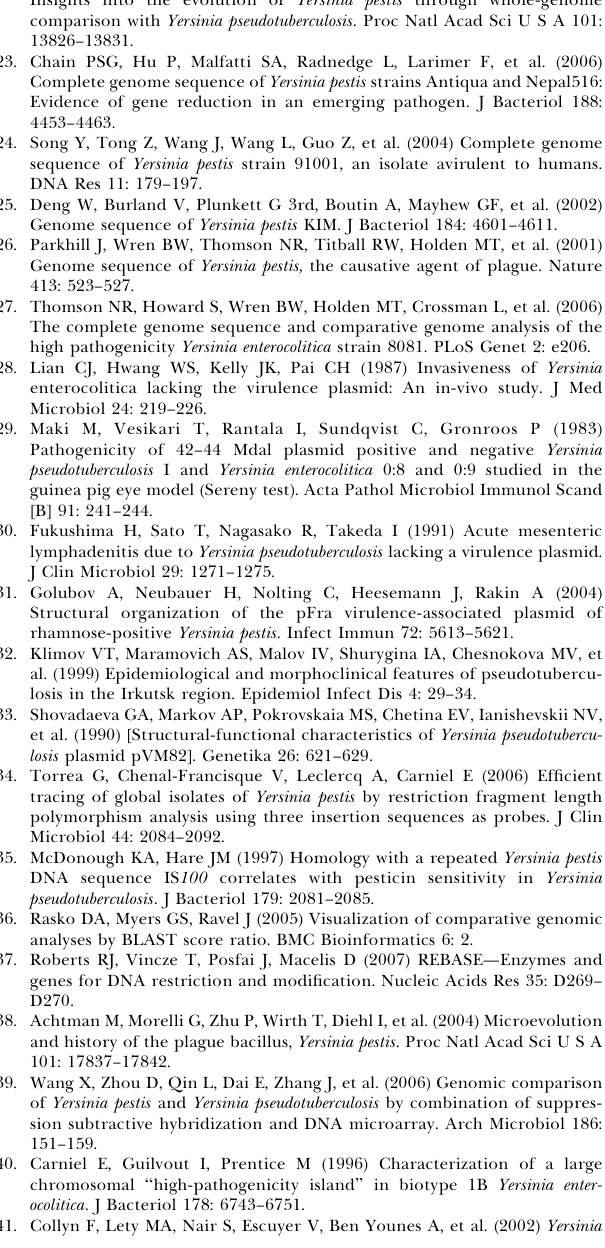
Table S5. Strain-Specific Genes in the Y. pseudotuberculosis IP32953 Genome Table S6. Genomic Regions Generating Genomic Plasticity in the Y. pseudotuberculosis IP31758 Genome Table S7. Primer